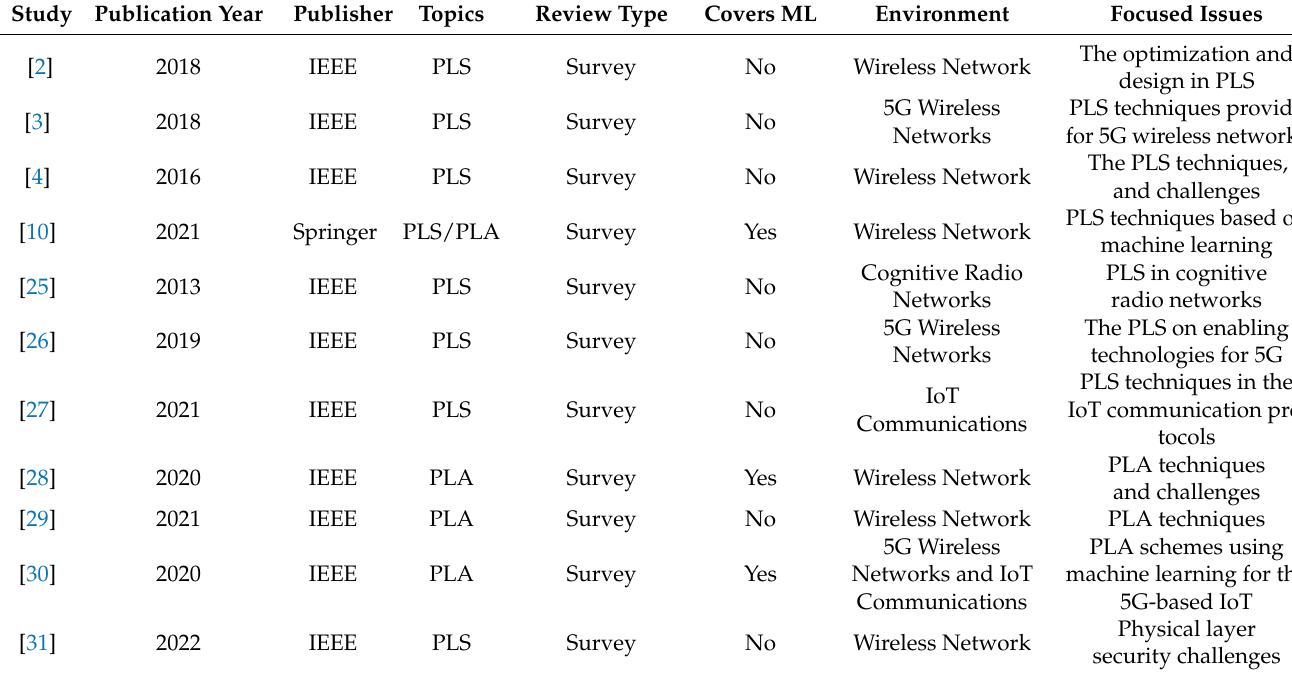
Table 1. Comparison of related